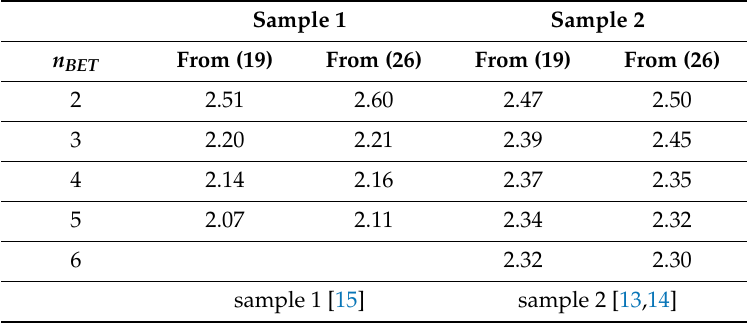
Table 1. Results of calculations of the fractal dimension with Equations (19) and